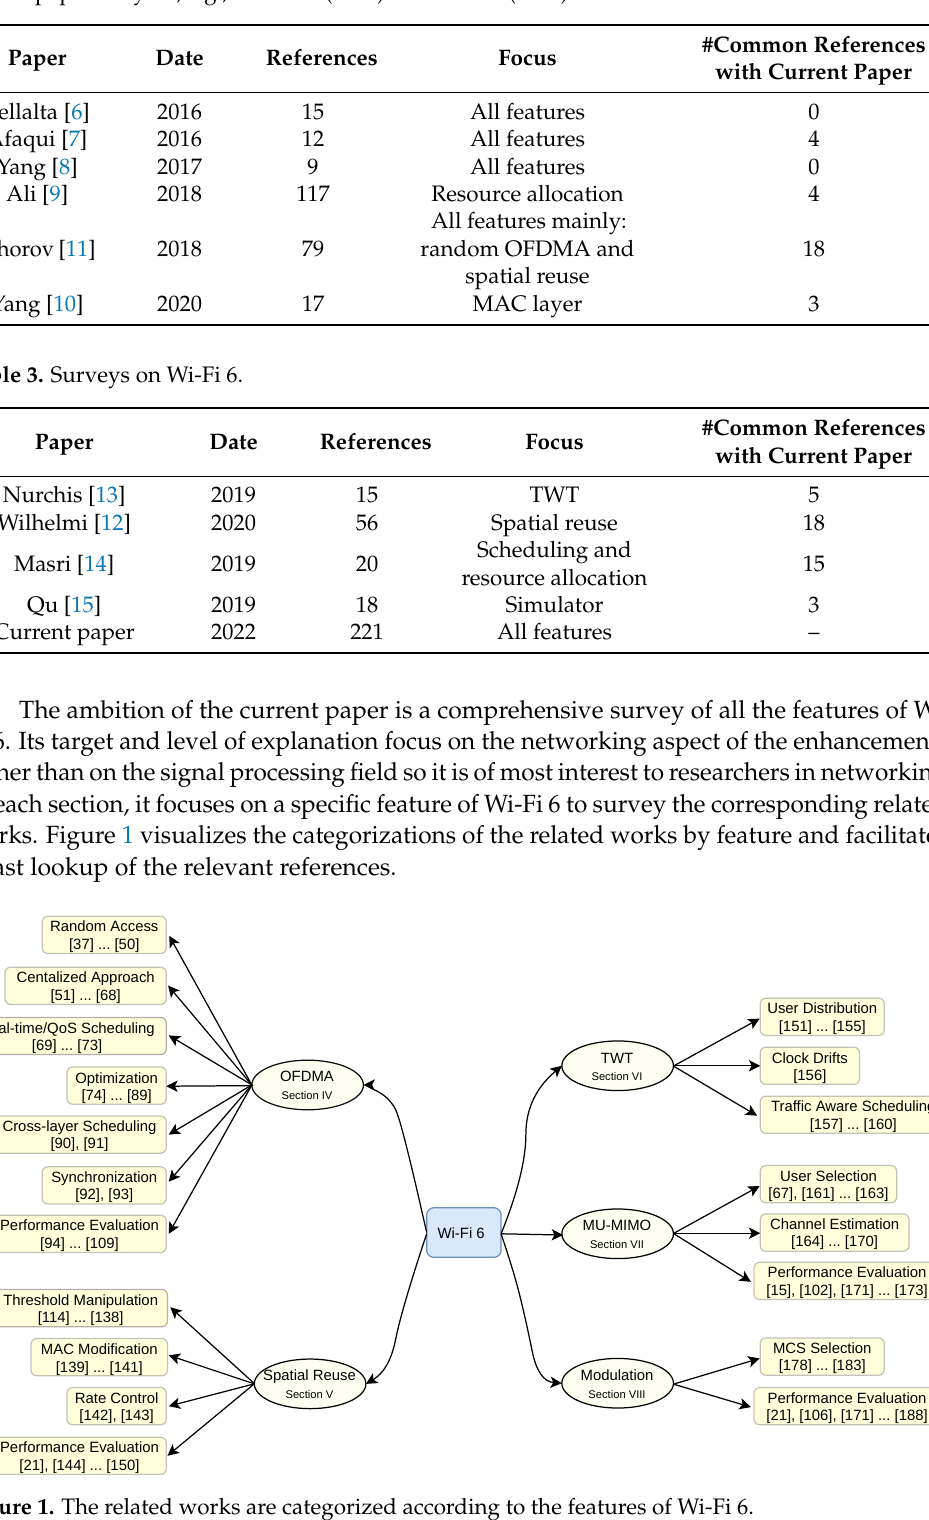
Table 2. Tutorials on Wi-Fi 6. The current paper is based on the official standard (May 2021), whereas earlier papers rely on, e.g., Draft 3.0 (2018) or Draft 4.0 (2019).